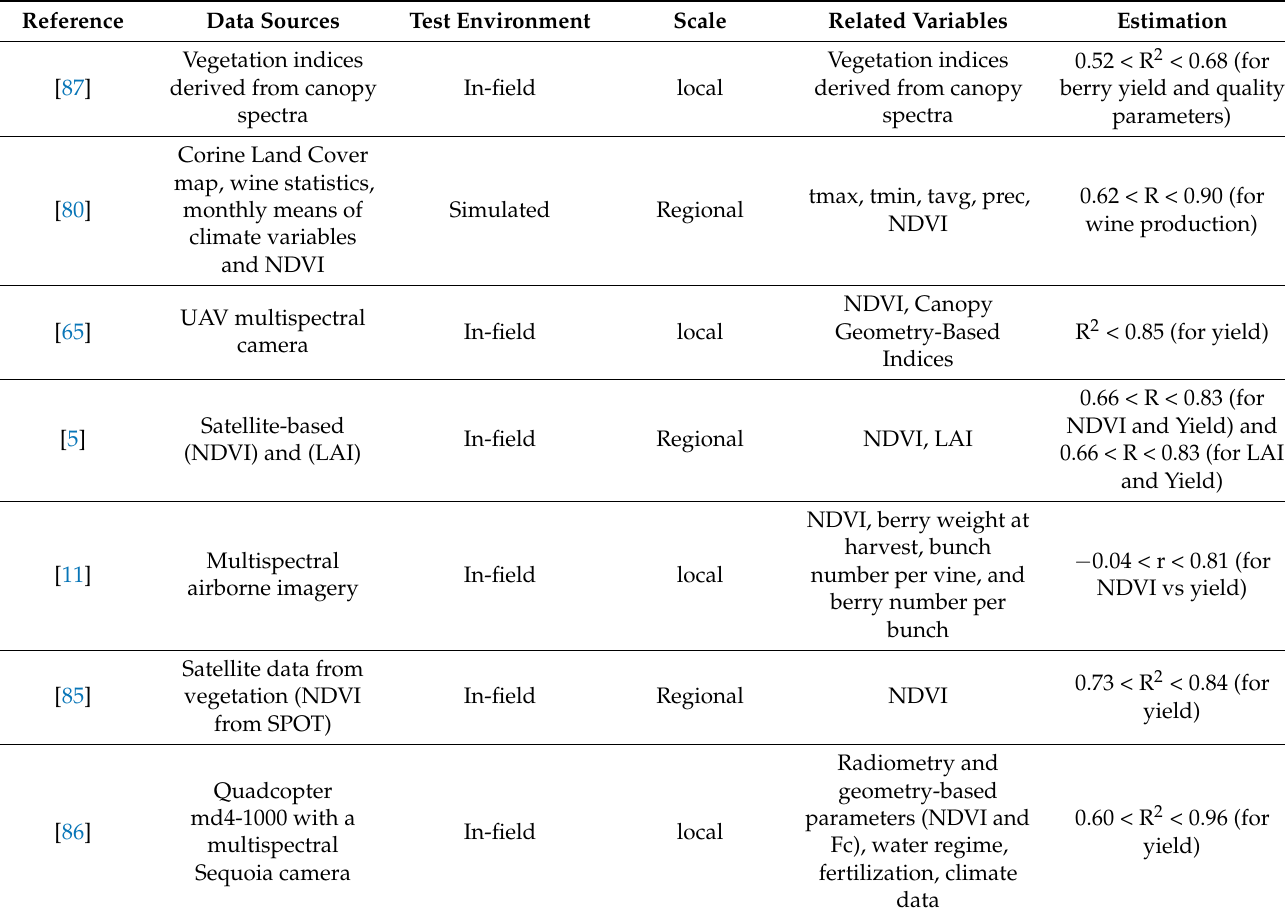
Table 3. Summary of records included in the systematic review (data-driven models based on vegetation indices).